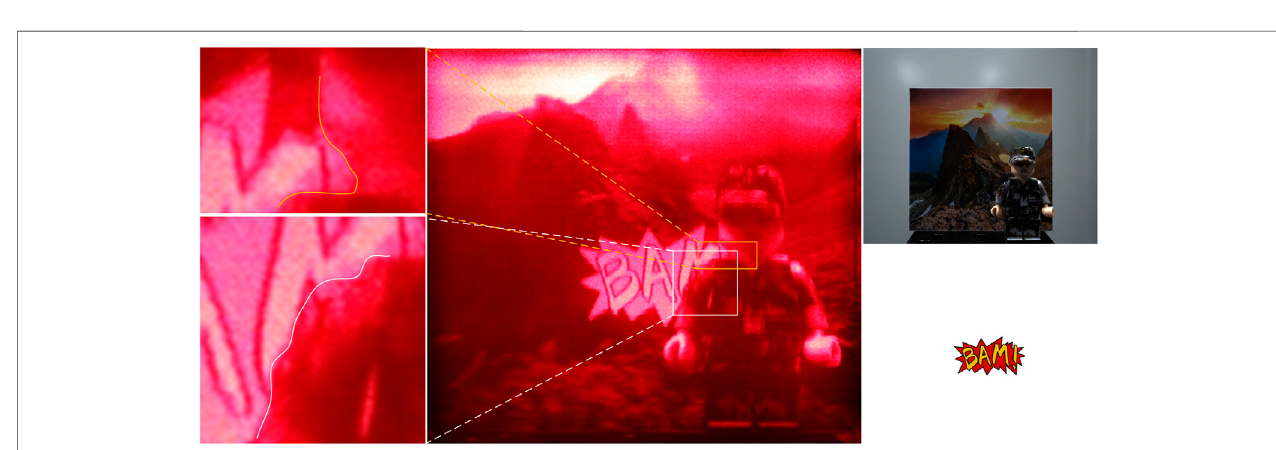
FIGURE 12 | Effect display of a new scene of augmented-reality display.